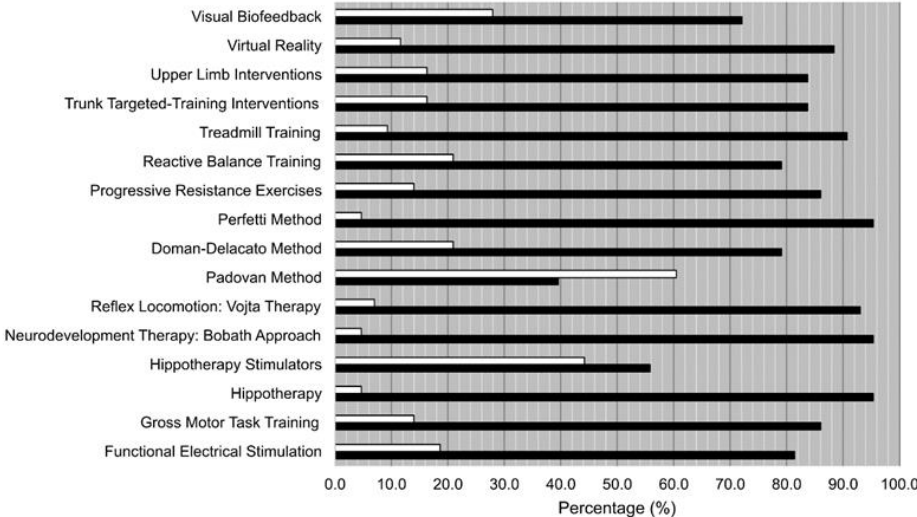
Figure 1. Knowledge of each one of the techniques, therapies and interventions listed on the survey. No (white bars)/Yes (black